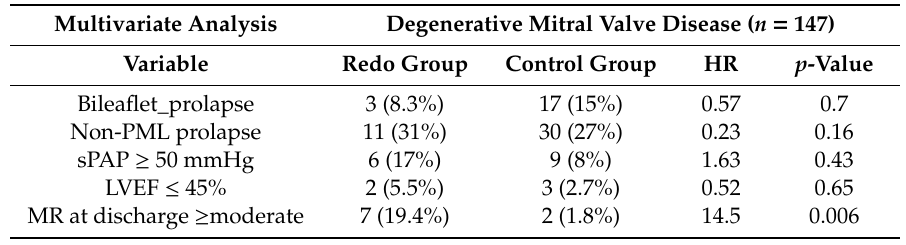
Table 3. Risk factors for redo MV surgery in the degenerative mitral regurgitation (DMR) subgroup (Cox regression model). Parameters were collected prior to initial mitral valve repair.